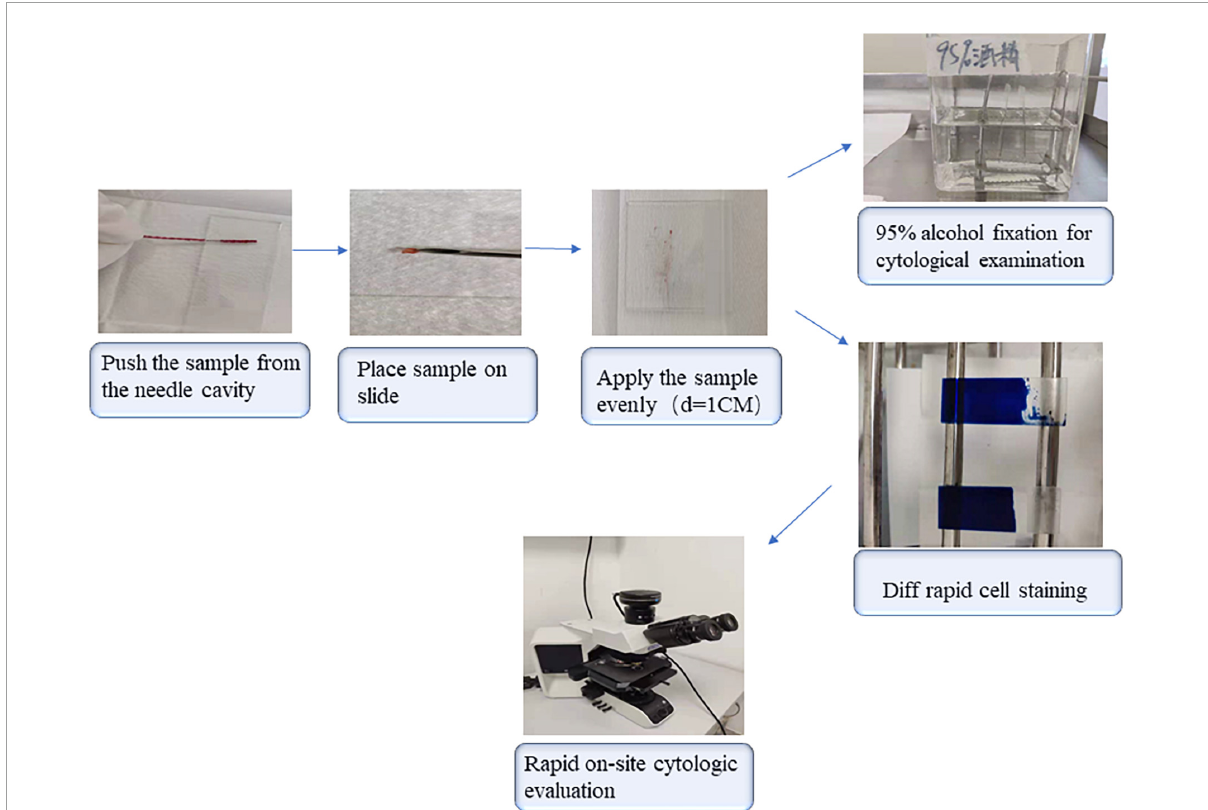
FIGURE2 A flow diagram of procedure